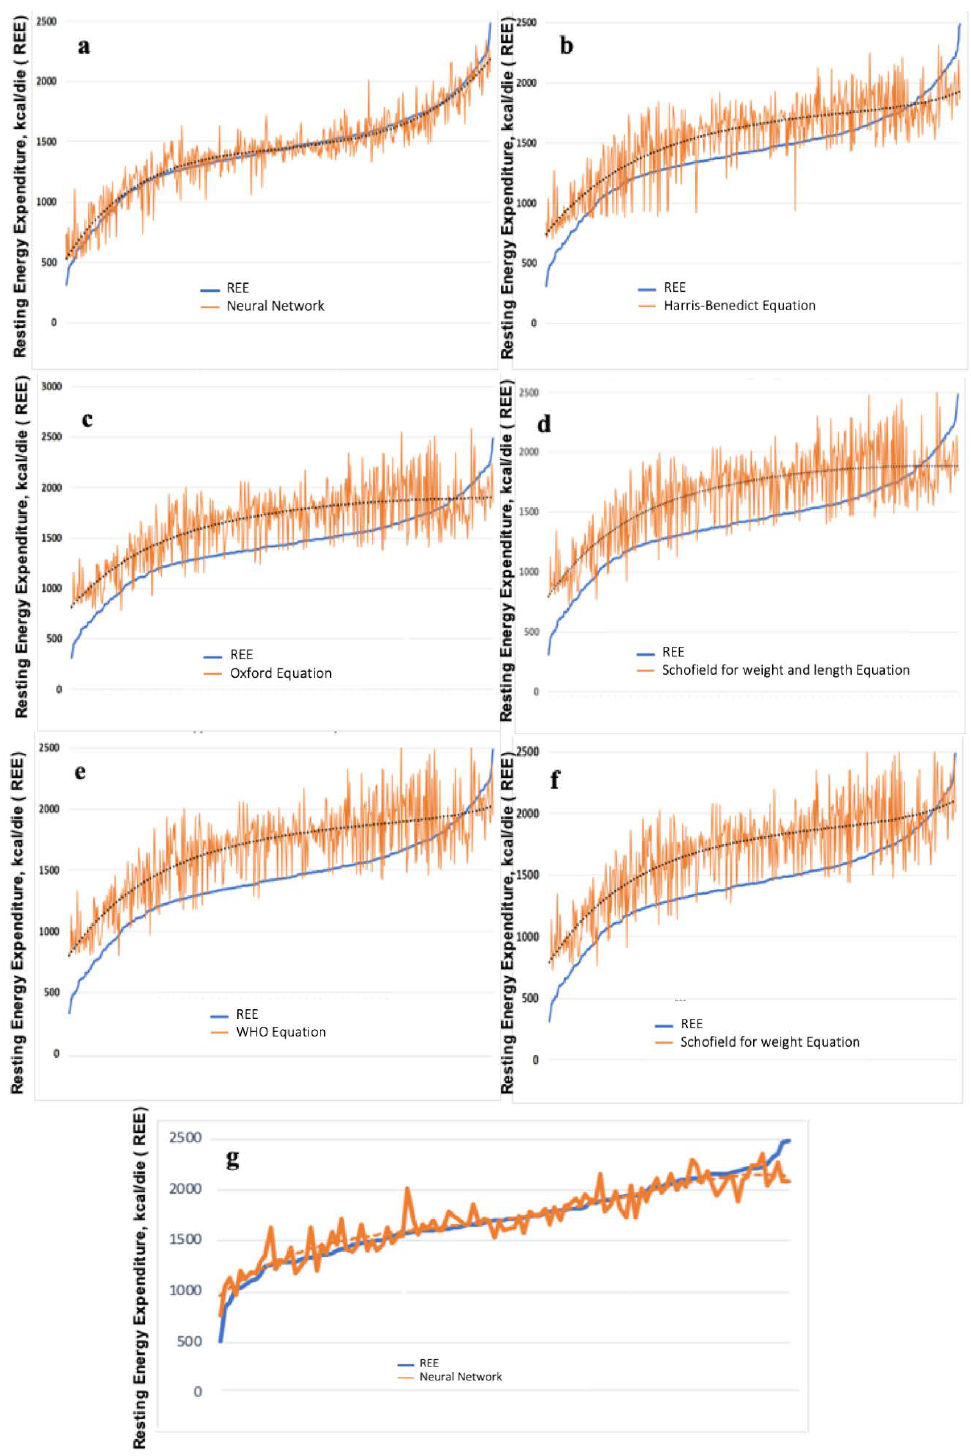
Figure 2. True REE approximation in total population and in obese subgroup. Approximation with neural networks ( a ) and the comparative results obtained with Harris–Benedict ( b ), Oxford ( c ), Schofield for weight and length ( d ), WHO ( e ), and Schofield for weight equations ( f ). Prediction of REE in obese children with the best ANN ( g ). The blue line expresses the true REE values, the orange line is the corresponding fitting of the method under evaluation, and the dotted line is the tendency line described by a five-degree polynomial